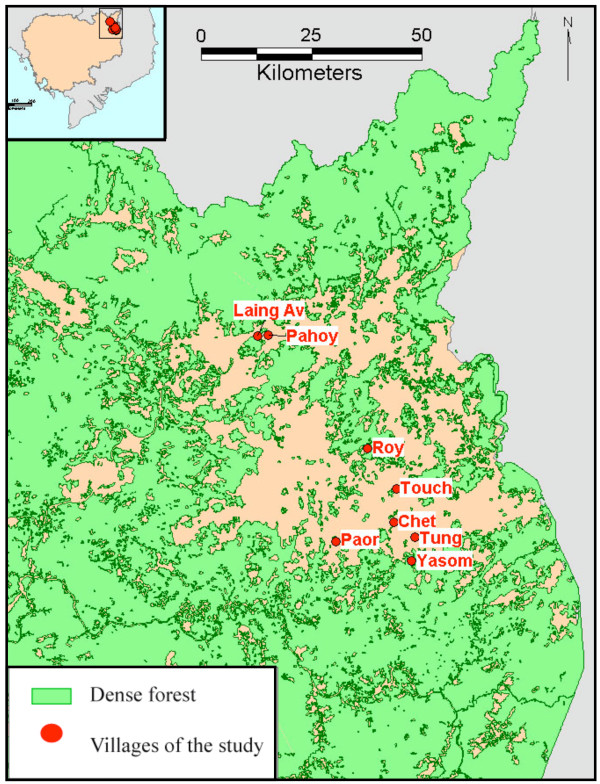
The study area and villages in Rattanakiri province, and their location in Cambodia. (lat/long: Yasom 13.583/107.283; Roy 13.814/107.193; Paor 13.624/107.125; Chet 13.662/107.246; Tung 13.631/107.290; Touch 13.731/107.253; Laing Av 14.046/106.964; Pahoy 14.047/106.987)